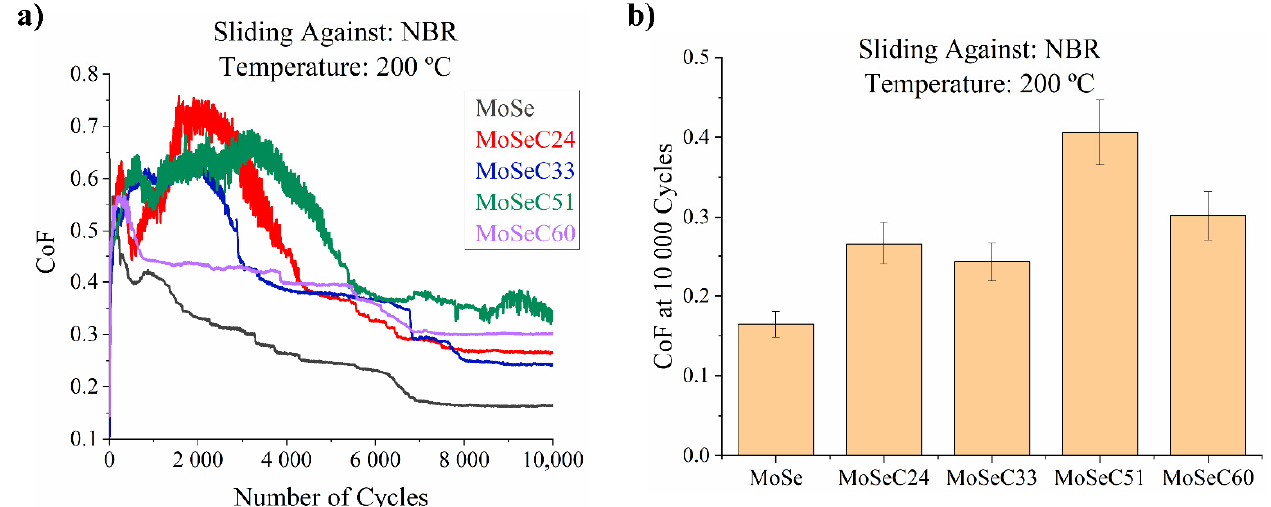
◦ C: ( a ) friction curves; ( b ) final